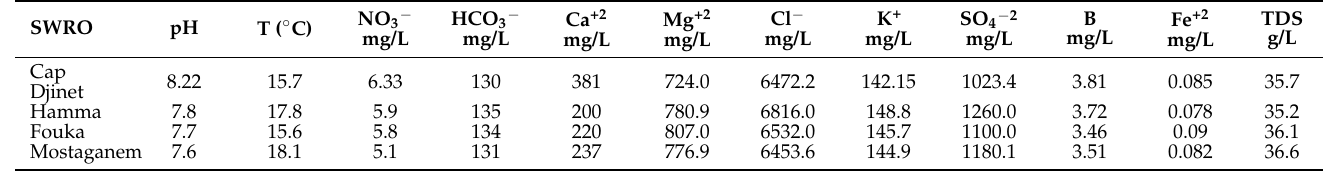
Table 7. The physicochemical parameters of seawater for different places.